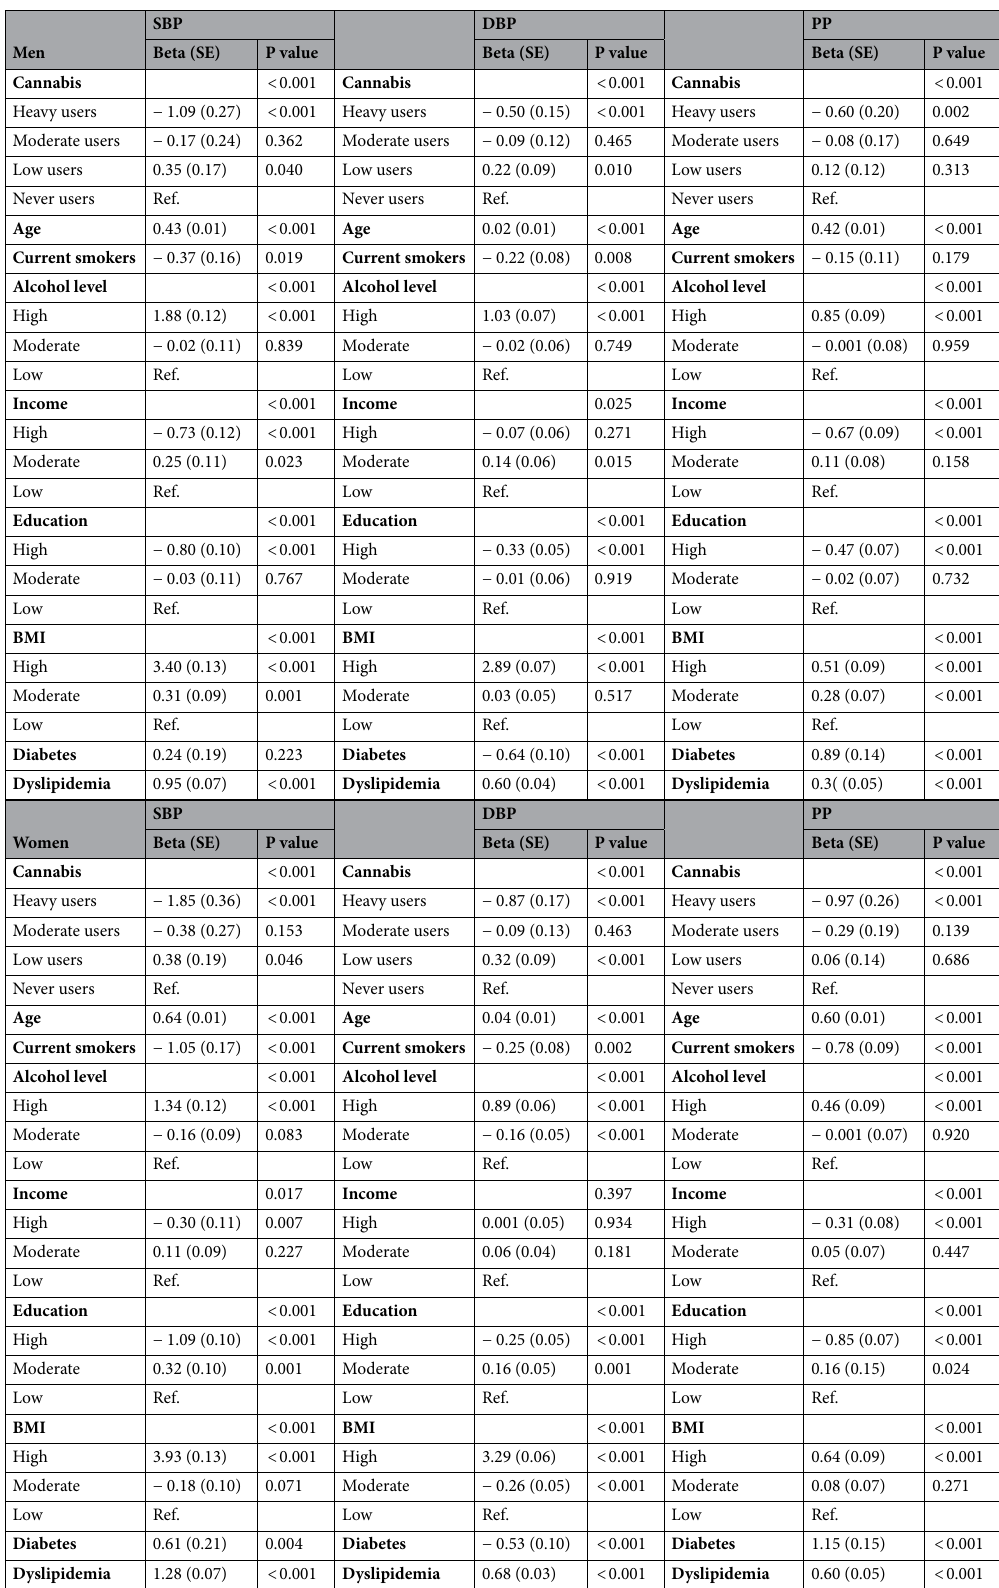
Table 2. Multiple gender linear regression models for the relationship between cannabis use and blood pressure (SBP, DBP and PP). SBP systolic blood pressure, DBP diastolic blood pressure, PP pulse pressure, BMI body mass